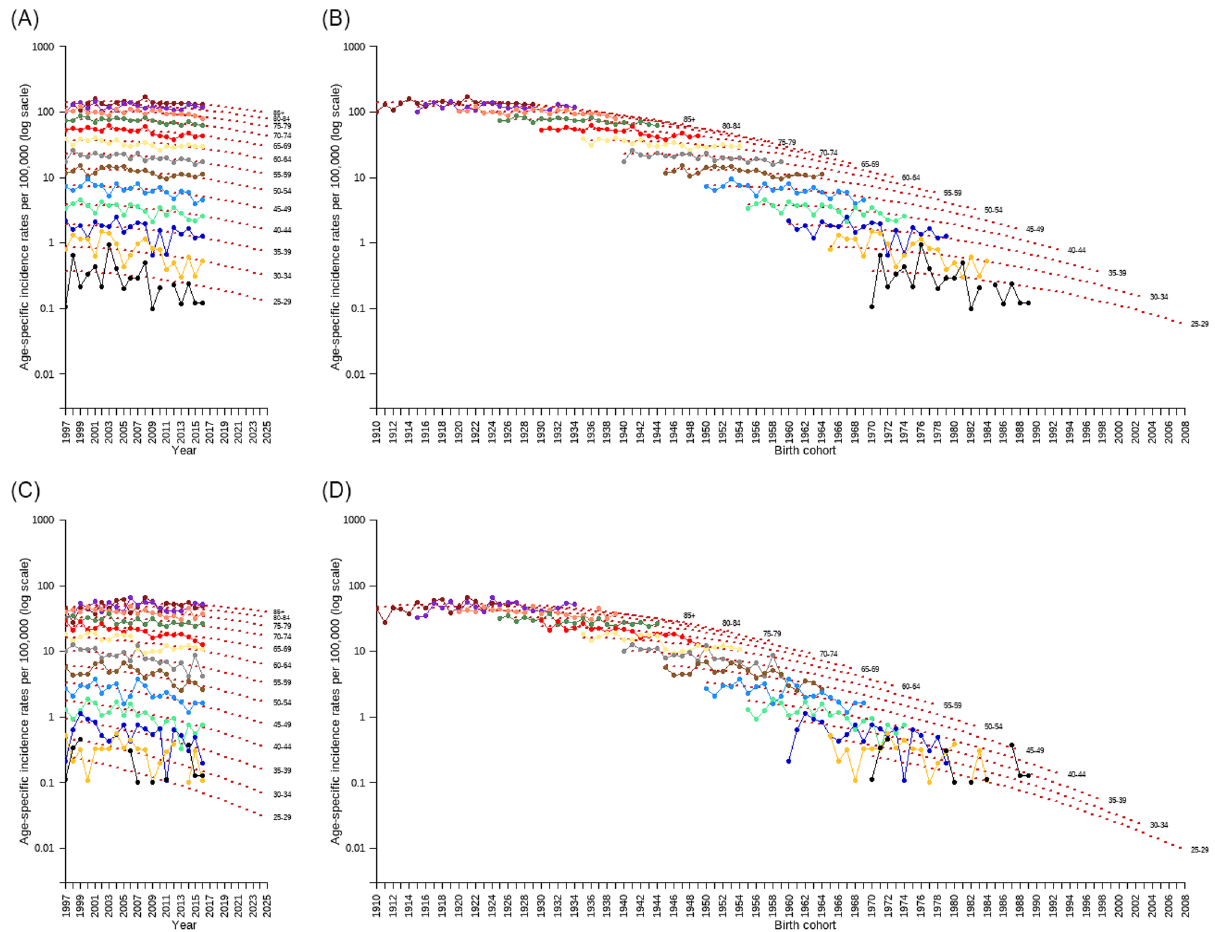
Figure 4. Age-specific bladder cancer incidence rates from 1997 to 2016 and projections from 2017 to 2025 for both sexes by calendar year ( A , C ) and birth cohort ( B , D